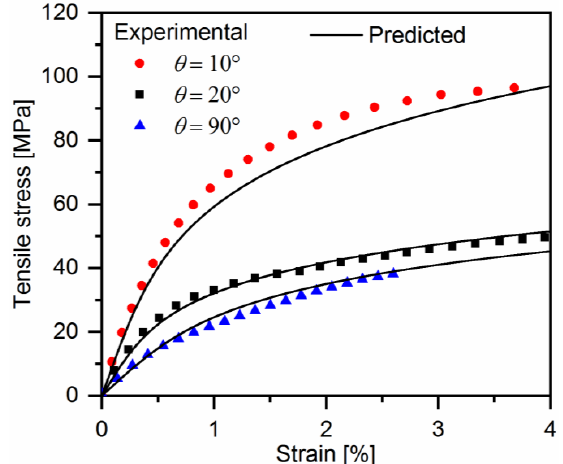
Figure 14. Comparison of predicted axial stress-strain curves and experimental results of a quasi-UD E-glass/polypropylene composite.